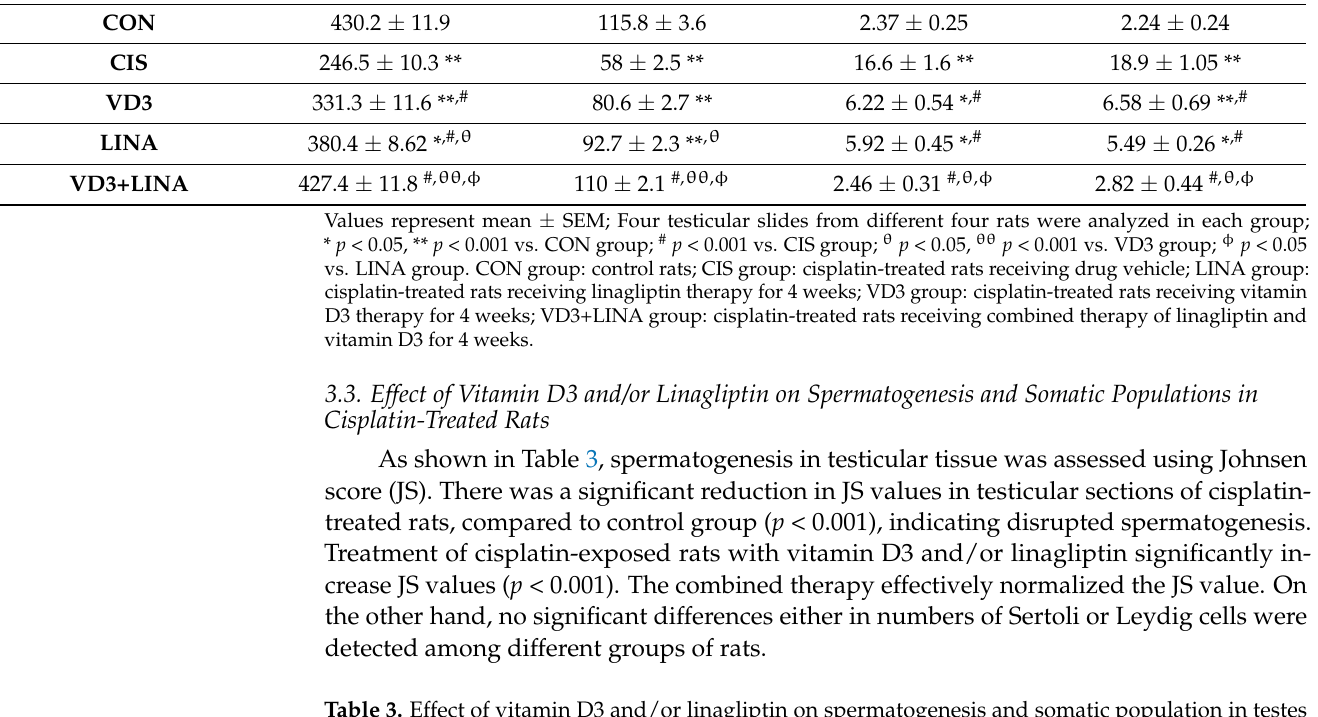
Table 3. Effect of vitamin D3 and/or linagliptin on spermatogenesis and somatic population in testes of cisplatin-treated